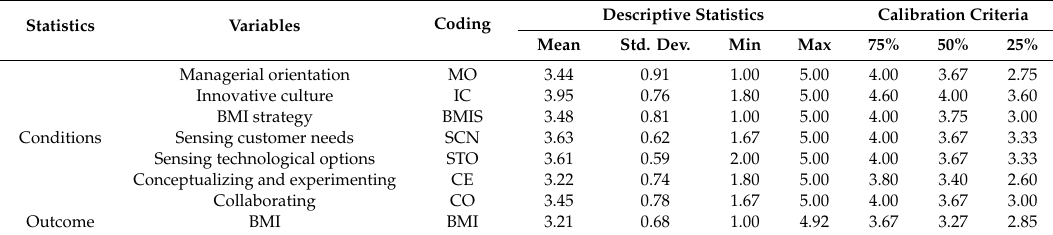
Table 3. FsQCA: Descriptive statistics of the conditions and outcome.